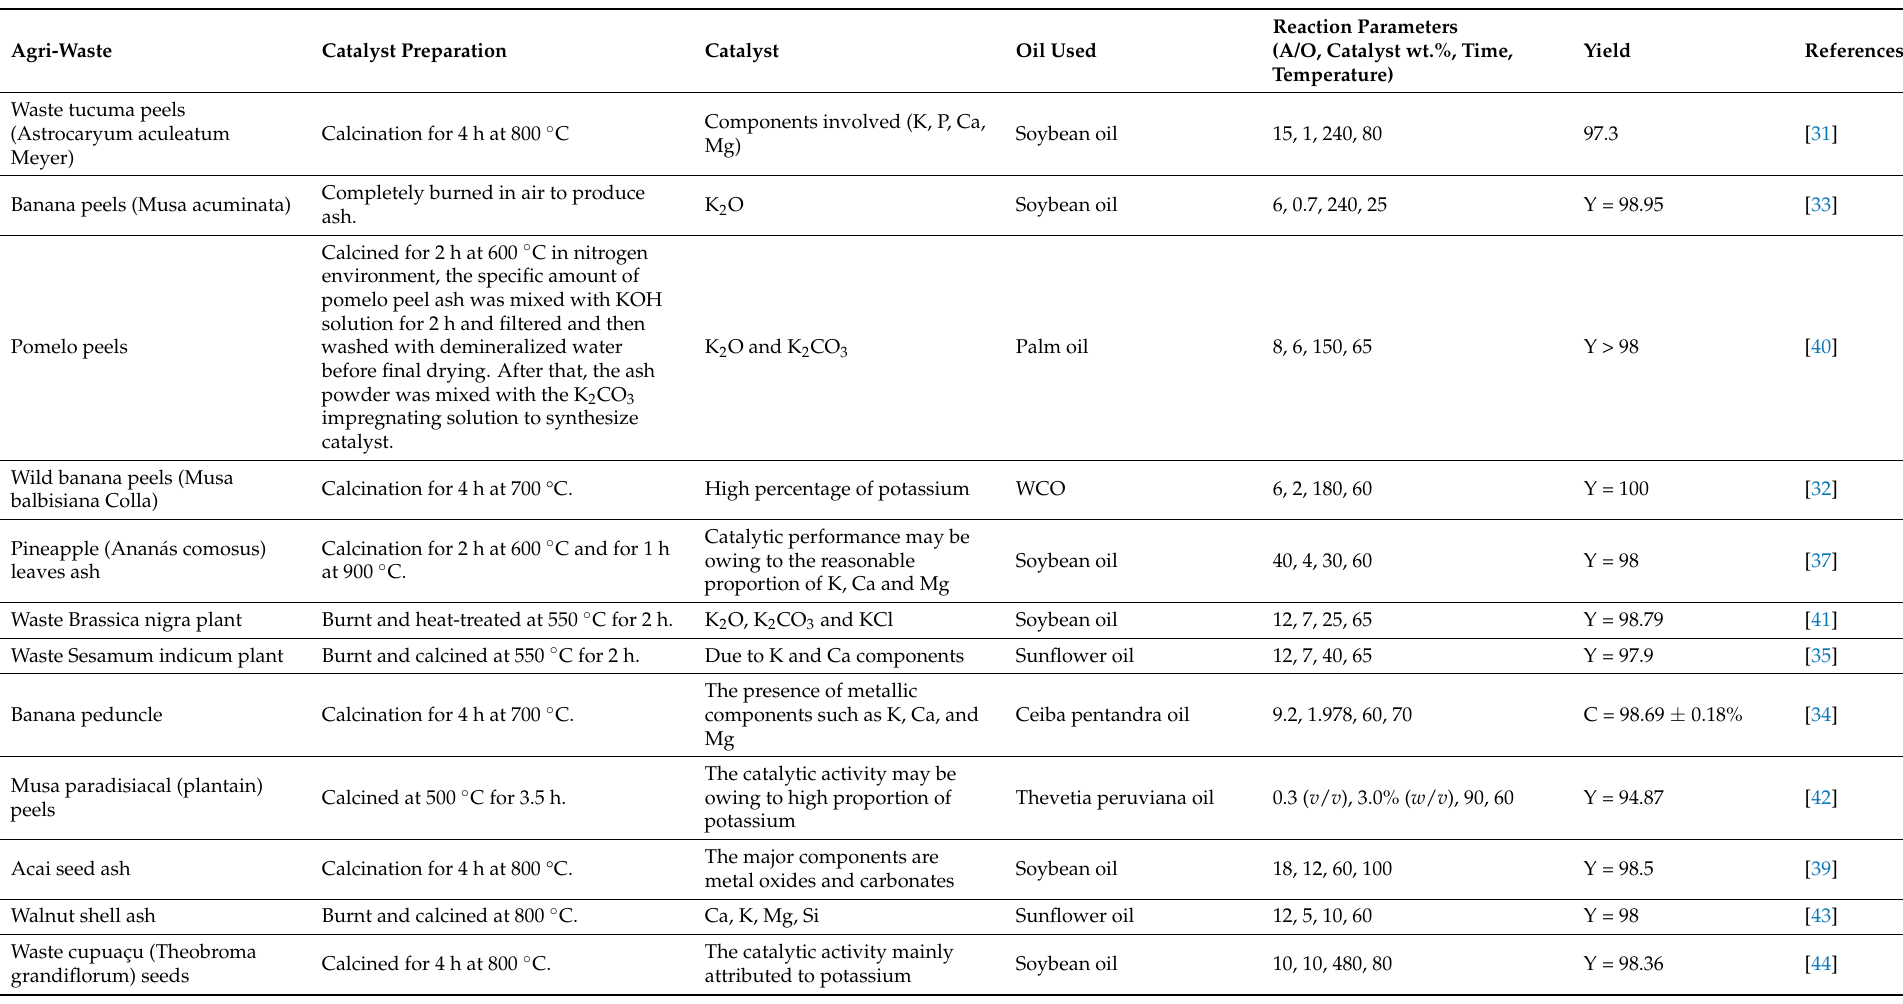
Table 1. Agri-waste-derived catalysts for biodiesel